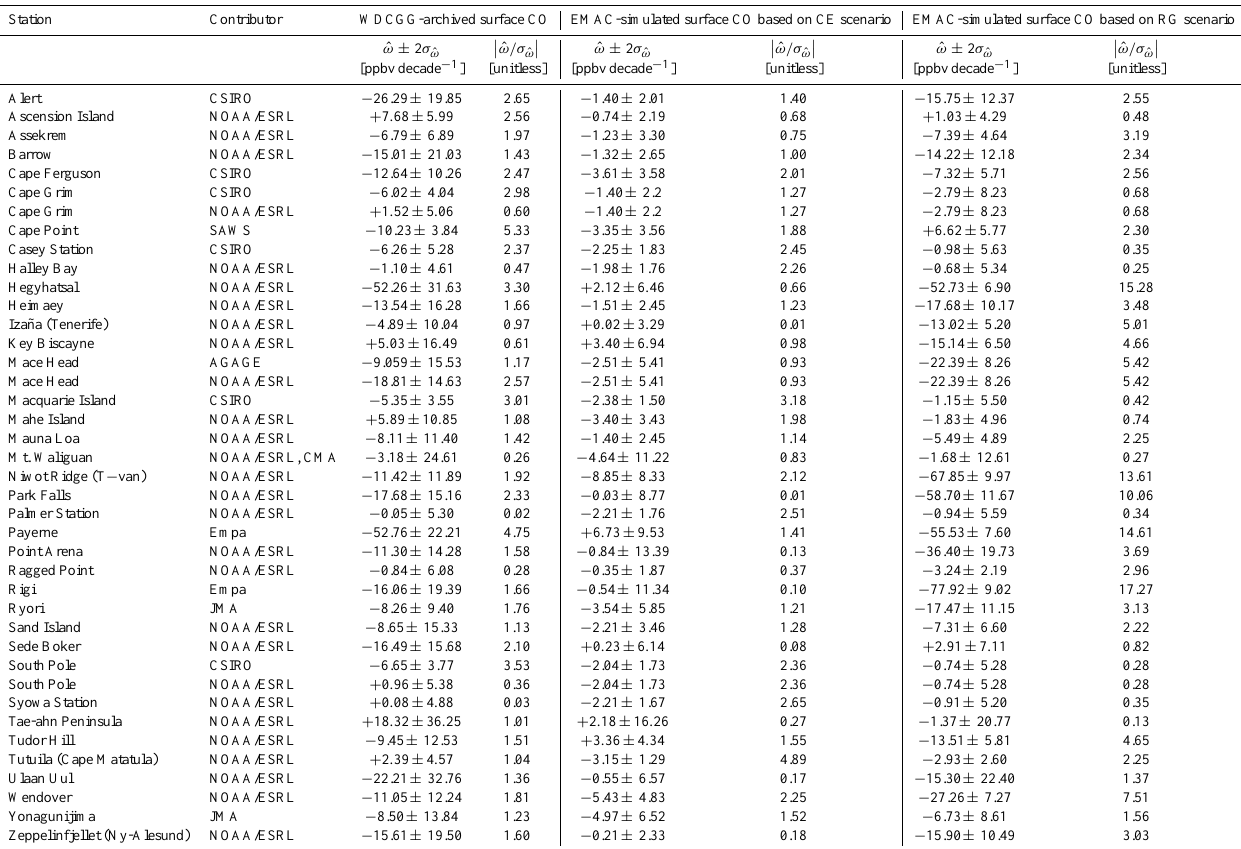
Table 4. Trend estimate ( ˆ ω) and corresponding significance value ( 95% confidence level. In this study, we define ˆ ω as a statistically significant trend at a 95% confidence level when (Tiao et al., 1990; Weatherhead et al.,